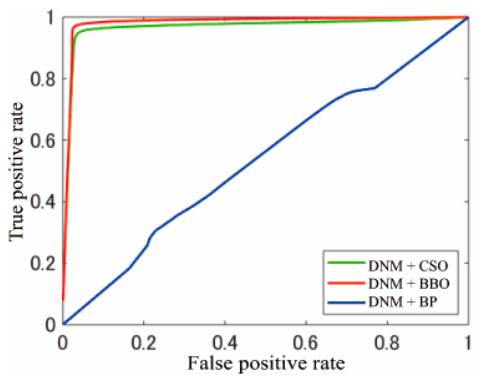
Figure 10. ROC of each method in F2.